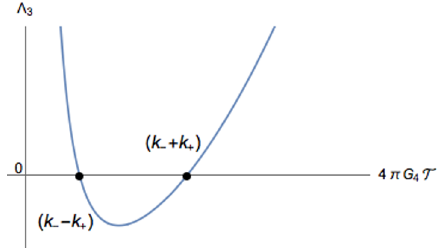
Figure 4. The dimensionless 3d-cc vs the